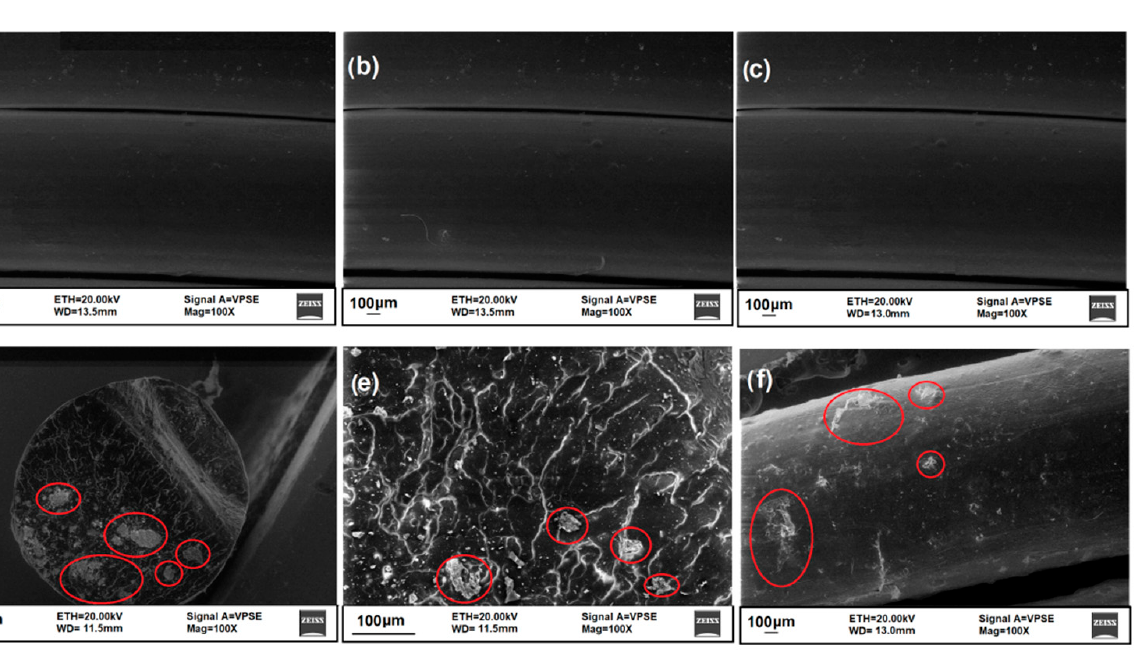
SEM analyses were performed on the filament section to observe the homogene- ity/heterogeneity of the structure and on the outer surfaces to study the surface rough- ness. Differences between the filaments at the outer surface level emerge from the results (Figure 4): the outer surfaces of the DF (Figure 4a), AF (Figure 4b), and BF (Figure 4c) filaments are perfectly smooth, with no obvious discontinuities; the addition of C particles creates an irregular filament surface, and some discontinuities are observed (Figure 4f). In addition, while the sections of DF, AF, and BF filaments are homogeneous, the addition of C filler does not occur uniformly in the polymer matrix: ceramic particles can be dis- tinguished in the section of the composite CF (Figure 4d,e) and in some cases form large aggregates (highlighted in the SEM images with red marks).